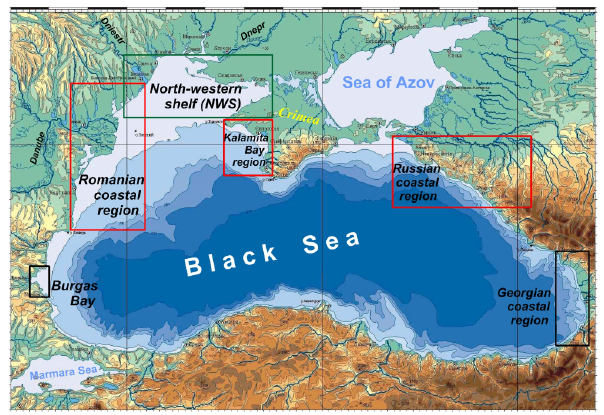
Fig. 2. The coastal regions implemented for the nested grid simu- lations. The numbers in the boxes indicate the grid points along the longitudinal and latitudinal directions,